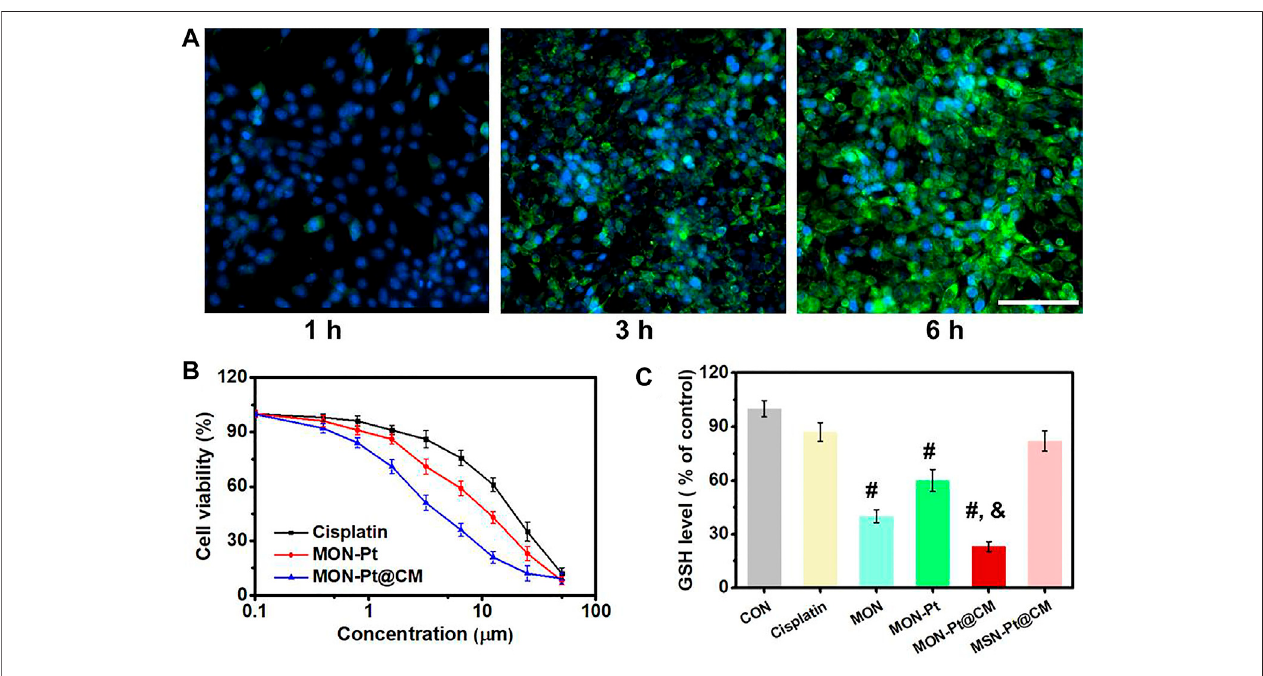
FIGURE 4 | MON-Pt@CM antitumor and GSH depletion in vitro . (A) Uptake of 4T1 cells incubated with FITC-MON-Pt@CM. Scale bars indicate 50 µm. (B) Cytotoxicity of MON-Pt@CM. (C) GSH depletion of MON-Pt@CM in 4T1 cells. #, & p < .05 compared with cisplatin group ( # ) and MSN-Pt@CM group ( & ).